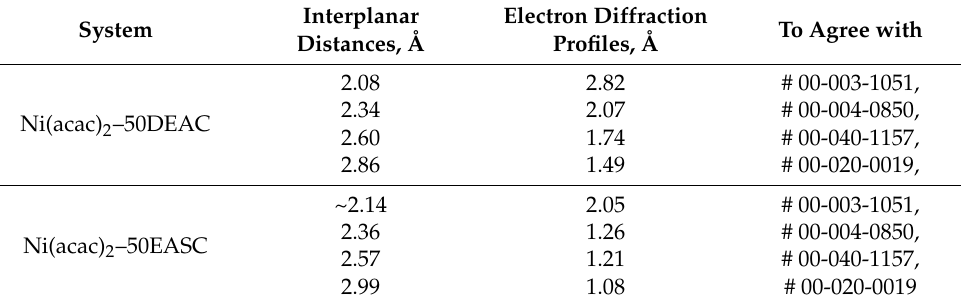
Table 3. Interplanar distances obtained during analysis of the atomic profiles and electron diffraction of Ni(acac) 2 –DEAC and Ni(acac) 2 –EASC samples presented in Table 2 (point 2). Data were taken from ref. [13,17]. Interplanar Electron Diffraction System To Agree with Distances, Å Profiles, Å